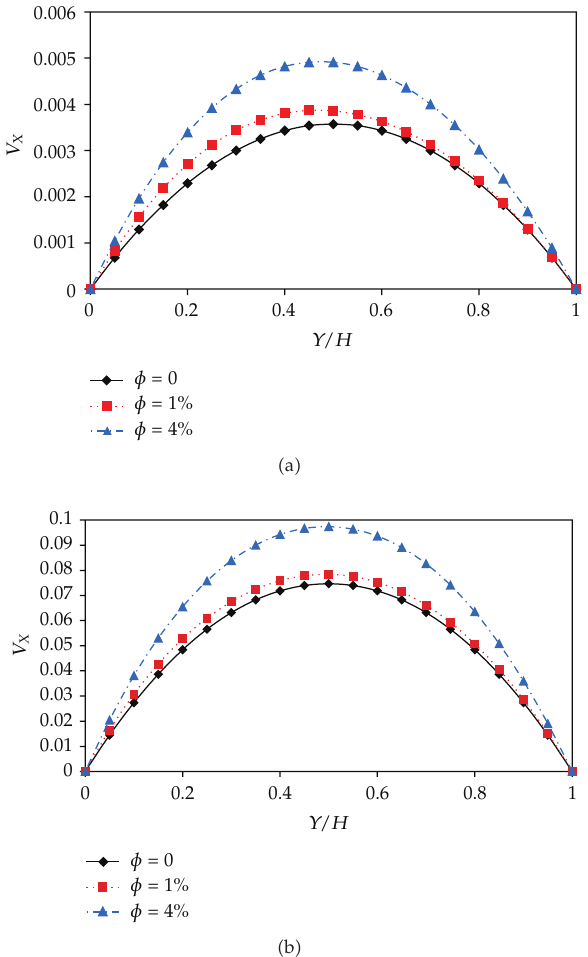
Figure 5: E ff ect of particle loading parameter φ on velocity profile at channel outlet for: (cid:3) a (cid:5) Re (cid:4) 50, (cid:3) b (cid:5) Re (cid:4)